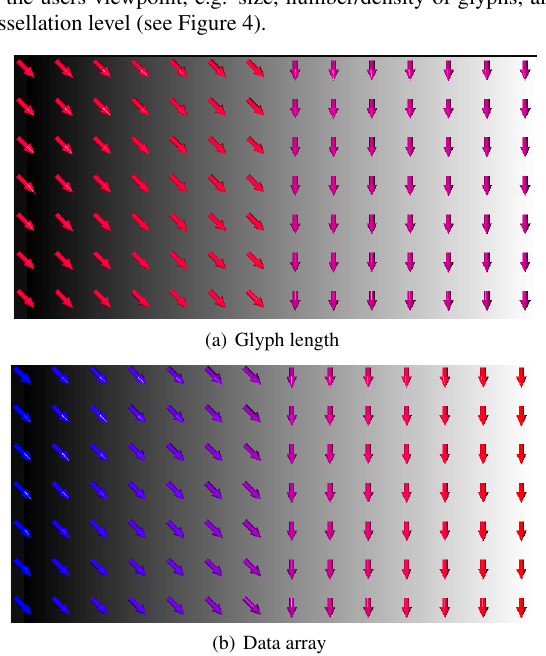
Figure 5: Color mapping glyph length (a) and color mapping data array (b)